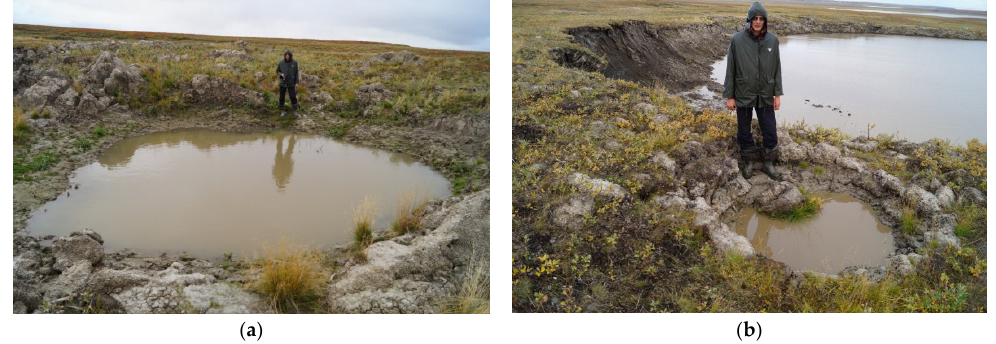
Figure 4. Hollows filled with water and surrounded by a ridge at GEC-2: ( a ) 10 m in diameter, 53 m to NE of the AMP (9 in Figures 7 and 8); ( b ) 1.5 m in diameter, 95 m to the NW of the AMP (photograph by E. A. Babkina, September 2017).